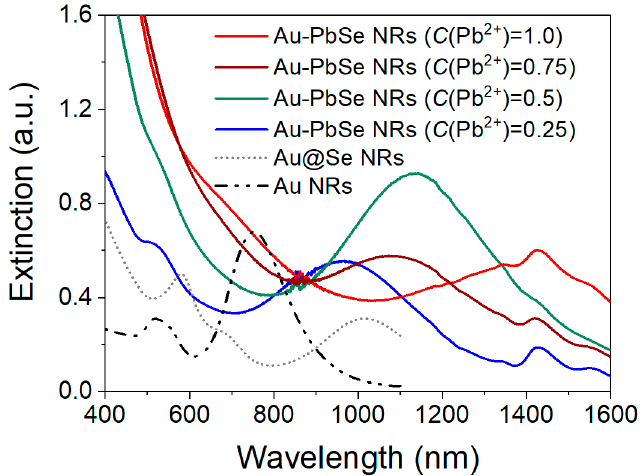
Figure 5. Extinction spectra of original Au NRs, Au@Se NRs with 13 nm shells, and the corresponding four parallel samples obtained at different initial Pb 2+ concentrations of 0.25 mM, 0.5 mM, 0.75 mM and 1.0 mM.